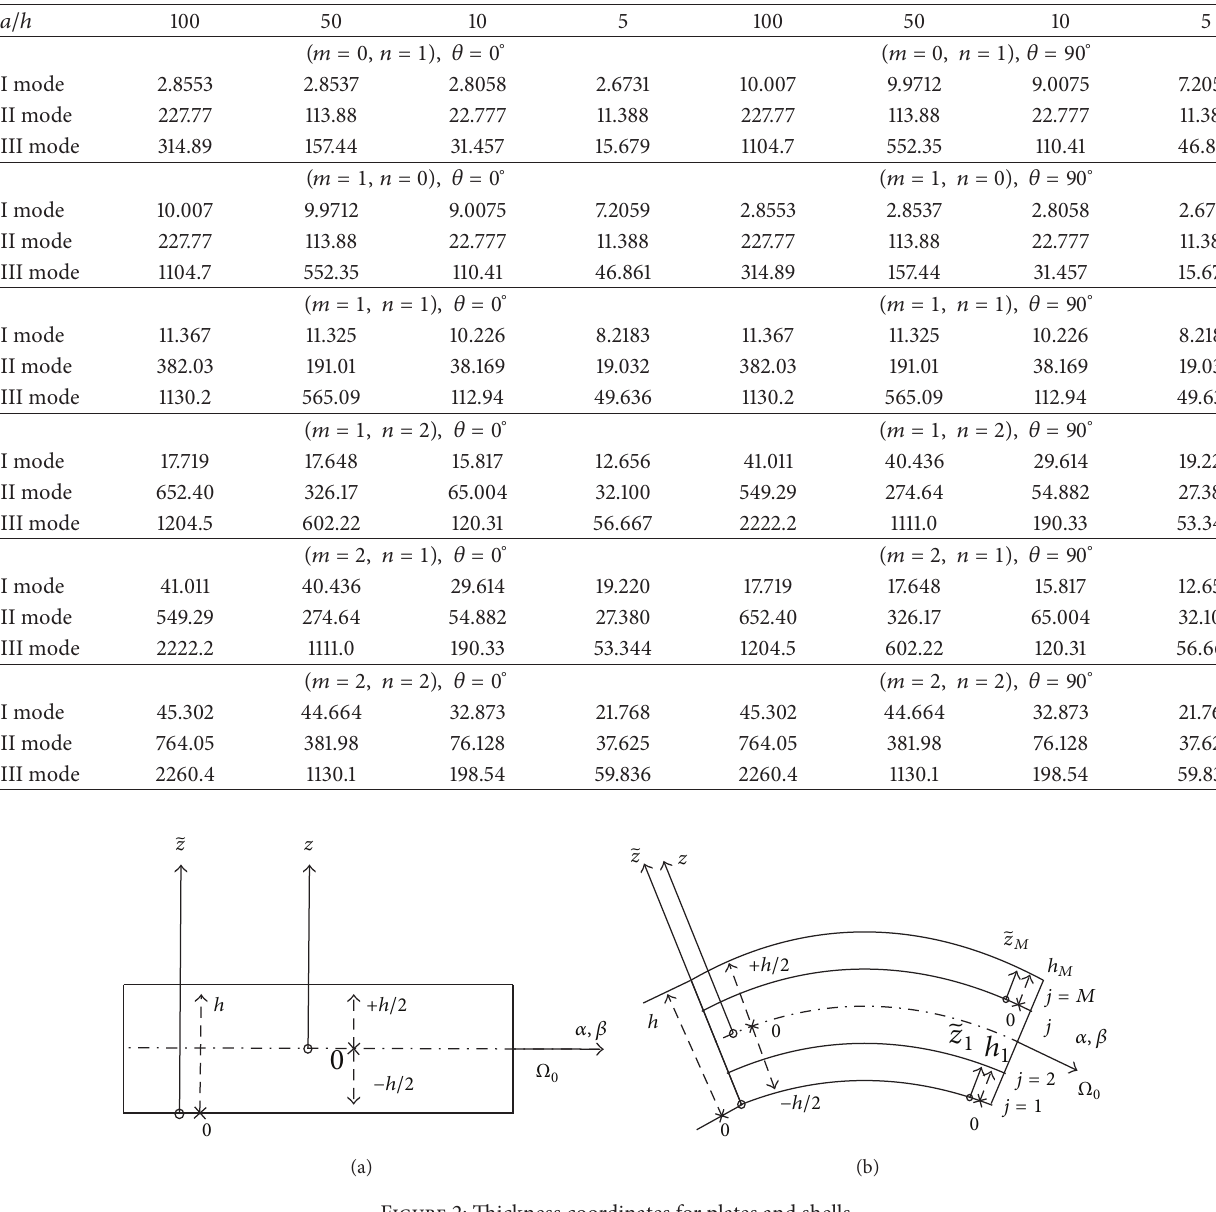
Table 6: Benchmark 2. Simply supported orthotropic square plate. First three vibration modes in term of no-dimensional circular frequency 𝜔 = 𝜔(𝑎 2 /ℎ)√𝜌/𝐸 𝑚 and 𝑛 . 𝑀 = 1 fictitious layers and 𝑁 = 18 order of expansion for the 2 for several combinations of half-wave numbers exponential matrix.